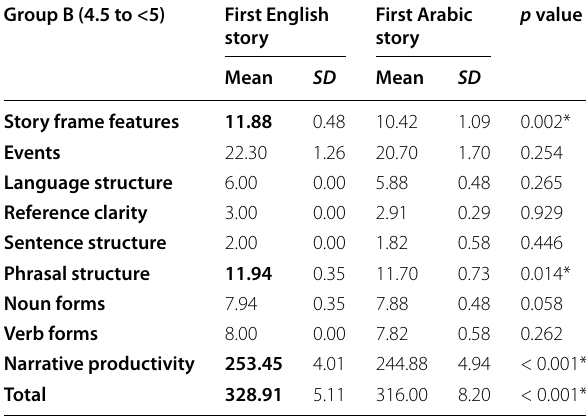
Table 9 Comparison between the scores of Arabic and English Narration Tests in the first story test (the doll) in age group B Group B (4.5 to <5)